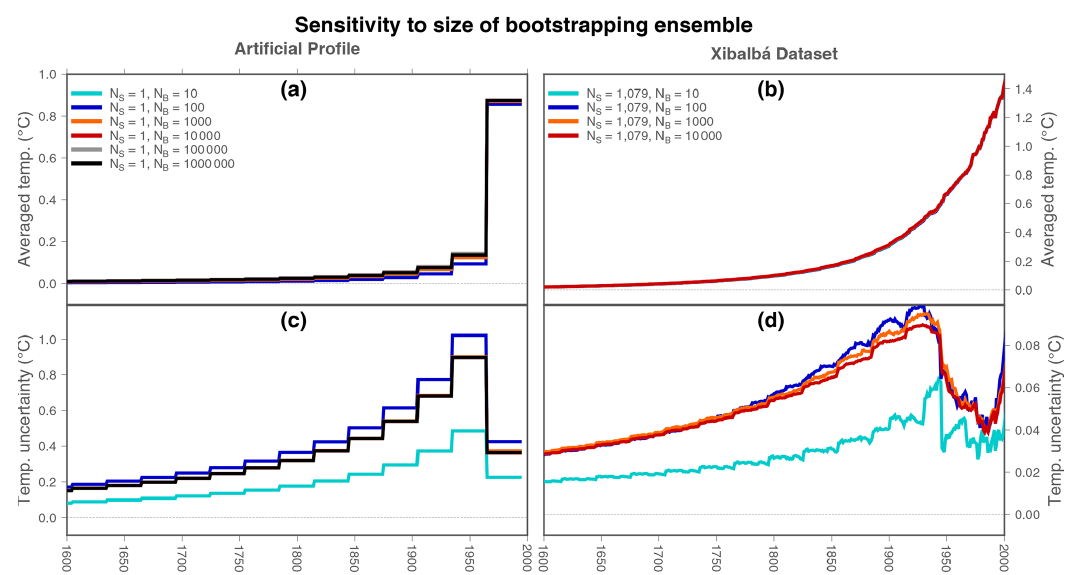
Figure 4. Temperature histories and uncertainty ranges in bootstrap inversions for different number of realizations. (a) Temperature histories for inversions of the artificial profile considering a population of one log (the artificial profile) ( N S = 1) and a different number of realizations ( N B from 10 to 1000000). (b) Temperature histories for inversions of the Xibalbá dataset considering a population of 1079 logs ( N S = 1079) and a different number of realizations ( N B from 10 to 10000). (c) Uncertainty range for inversions of the artificial profile considering the same sizes for the Sampling and Bootstrapping ensembles as in (a) . (d) Uncertainty range for inversions of the Xibalbá dataset considering the same sizes for the Sampling and Bootstrapping ensembles as in (b)